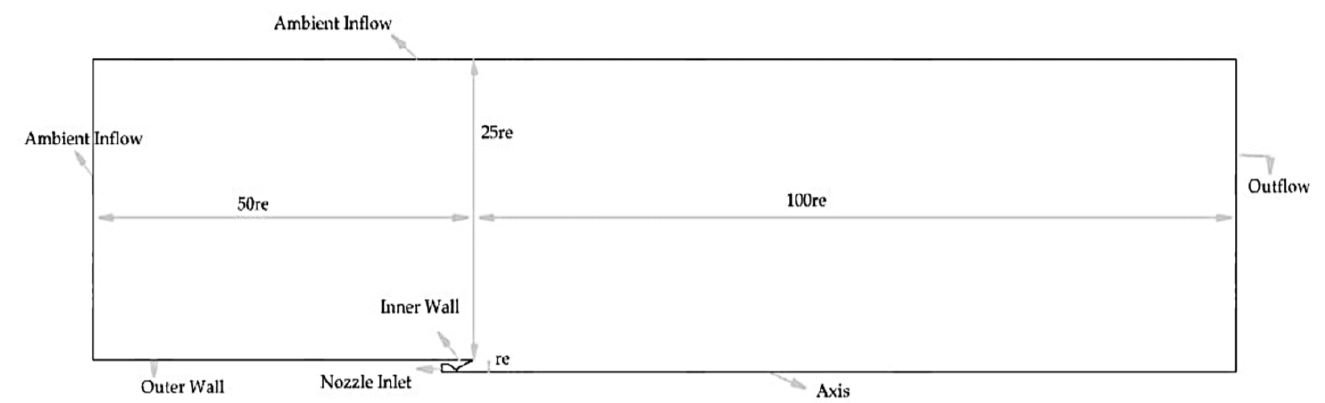
Figure 1. Computational domain and boundary conditions. Table 3. Grid independence study.